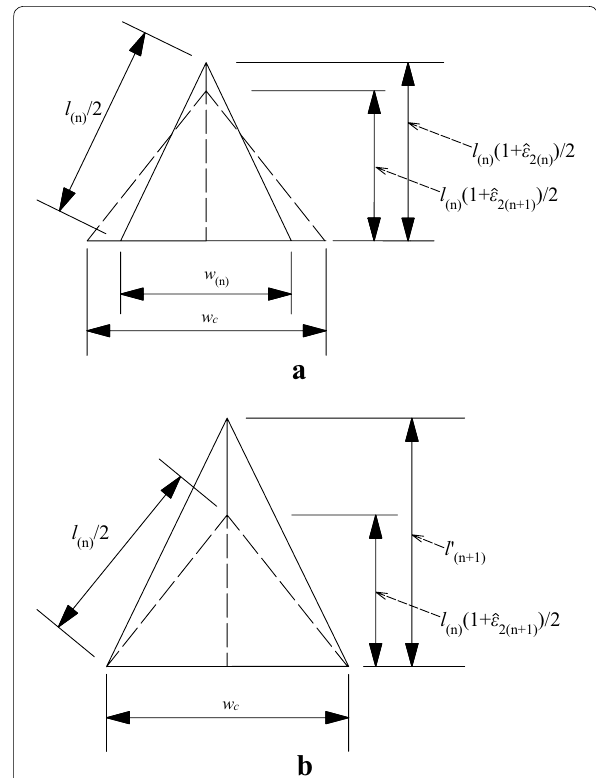
Fig. 4 The geometrical relationship between crack width and length. a Before crack propagation and b after crack